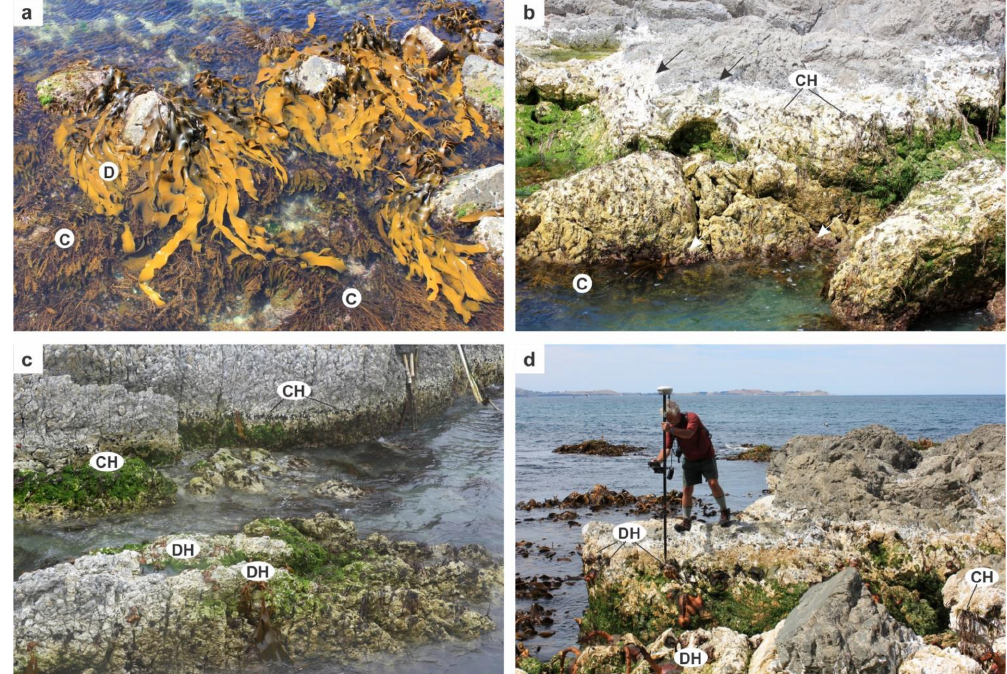
Figure 2. Field photographs of the intertidal zone and biota near Kaik¯oura (taken after the earthquake). (a) Healthy Durvillaea (mostly D. willana ) (D) and Carpophyllum (C) photographed at low tide. (b) Uplifted bedrock north of Paia Point showing living Carpophyllum (C) and dead Carpophyllum holdfast stumps (CH). Also note the living pink coralline algae at the waterline and bleached morbid coralline algae (arrows) and bright green Ulva . (c) Uplifted intertidal zone near the Kaik¯oura tide gauge, showing a distinctive line of Carpophyllum holdfasts (CH) and dispersed Durvillaea holdfasts (DH). (d) Uplifted intertidal zone near Paia Point. One of the authors (John Begg) is measuring the elevation of Durvillaea holdfasts (DH) and Carpophyllum holdfasts (CH) using RTK GNSS survey equipment. Note the distinctive white zone of dead coralline algae. Table 1. Calculation of uplift at the Kaik¯oura tide gauge (KAIT) using tide-gauge readings for high and low spring tides as well as high and low neap tides (see Sect. 3.1). Mean uplift is indicated in bold, derived by averaging the neap and spring low- and high-tide offsets. Spring tide Neap tide Uplift Pre-EQ Post-EQ Pre-EQ Post-EQ Spring diff. Neap diff. High tide 4.05m 3.1m 3.7m 2.75m 0.95m 0.95m Low tide 2.05m 1.1m 2.5m 1.5m 0.95m 1m Range 2m 2m 1.2m 1.25m Mean diff.